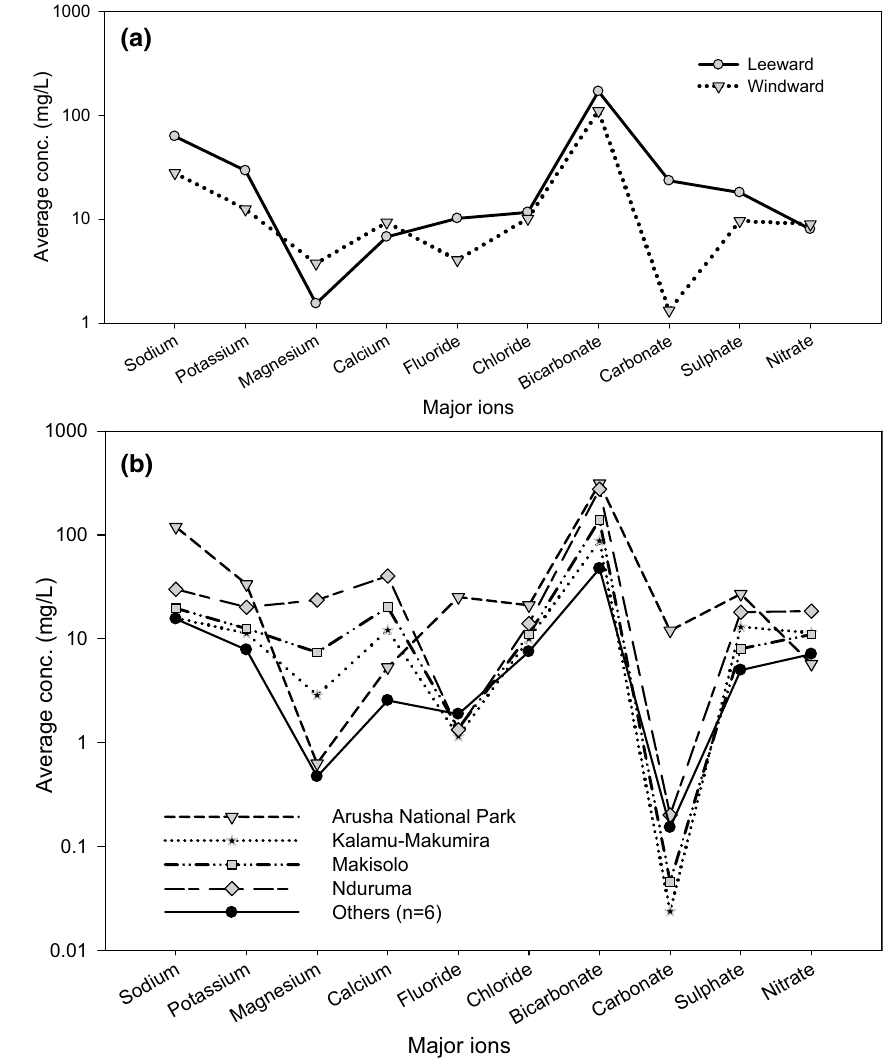
Fig. 15 Major ions characteriza- tion in springs. a Leeward and windward springs. b Windward springs showing elevated ions relative to other windward springs. All named springs are shown in Fig.